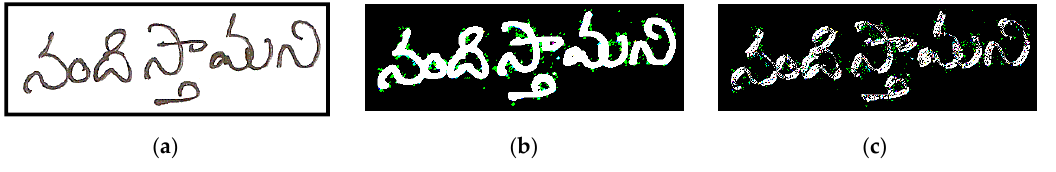
Figure 4. Illustration of: ( a ) handwritten Telugu word image, ( b ) its magnitude part and ( c ) its direction part.